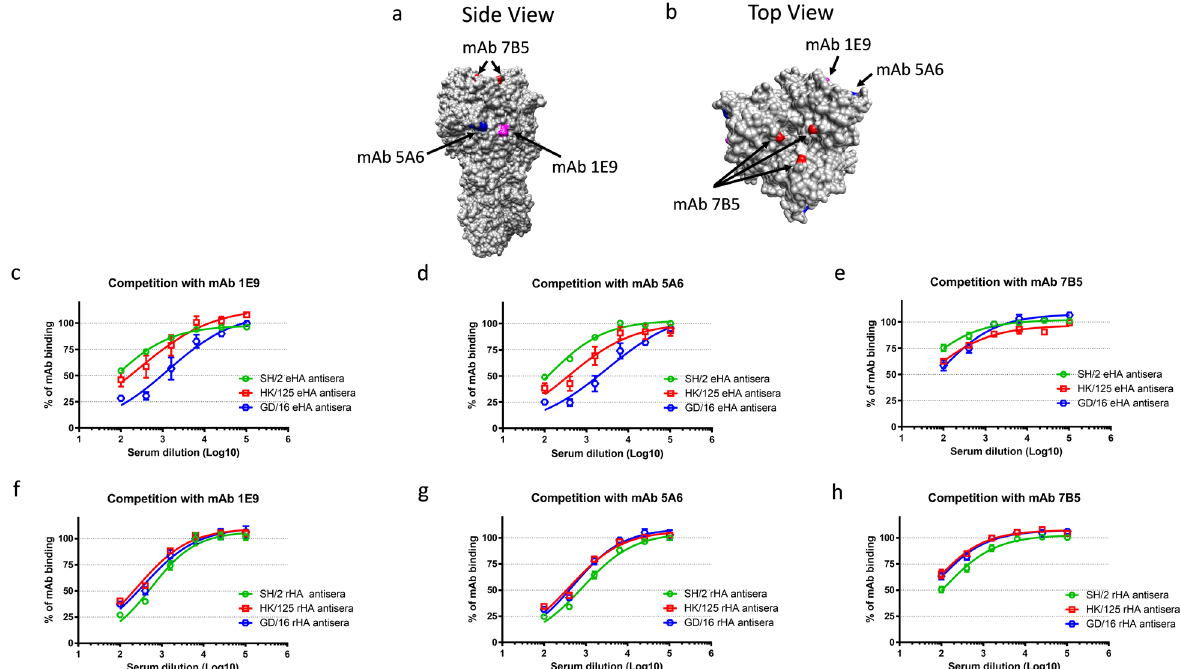
Fig. 7 Competition of H7 HA-speci fi c monoclonal antibodies with mouse hyperimmune sera. Hyperimmune sera were raised in mice administered with adjuvanted HA extracted (eHA) from H7N9 A/Shanghai/2/2013 (SH/2), A/Hong Kong/125/2017 (HK/125), or A/Guangdong/ 17SF003/2016 (GD/16) or H7 recombinant HAs (rHAs) at 500 ng/mouse. Hyperimmune sera were pooled and were used to compete with biotinylated H7-speci fi c monoclonal antibody (mAb) 1E9, 5A6 or 7B5, respectively. The % of residual biotinylated mAbs as compared to the wells that contained only biotinylated H7 mAbs were plotted by nonlinear regression. ( a ) Side view and ( b ) top view of epitopes targeted by mAbs 1E9 (magenta), 5A6 (blue) and 7B5 (red) using SH/2 HA trimer (PDB ID: 4LN6) as the template; ( c – h ) competition with 1E9, 5A6 and 7B5. Data are expressed as mean ± s.e.m ( n = 6 – 9